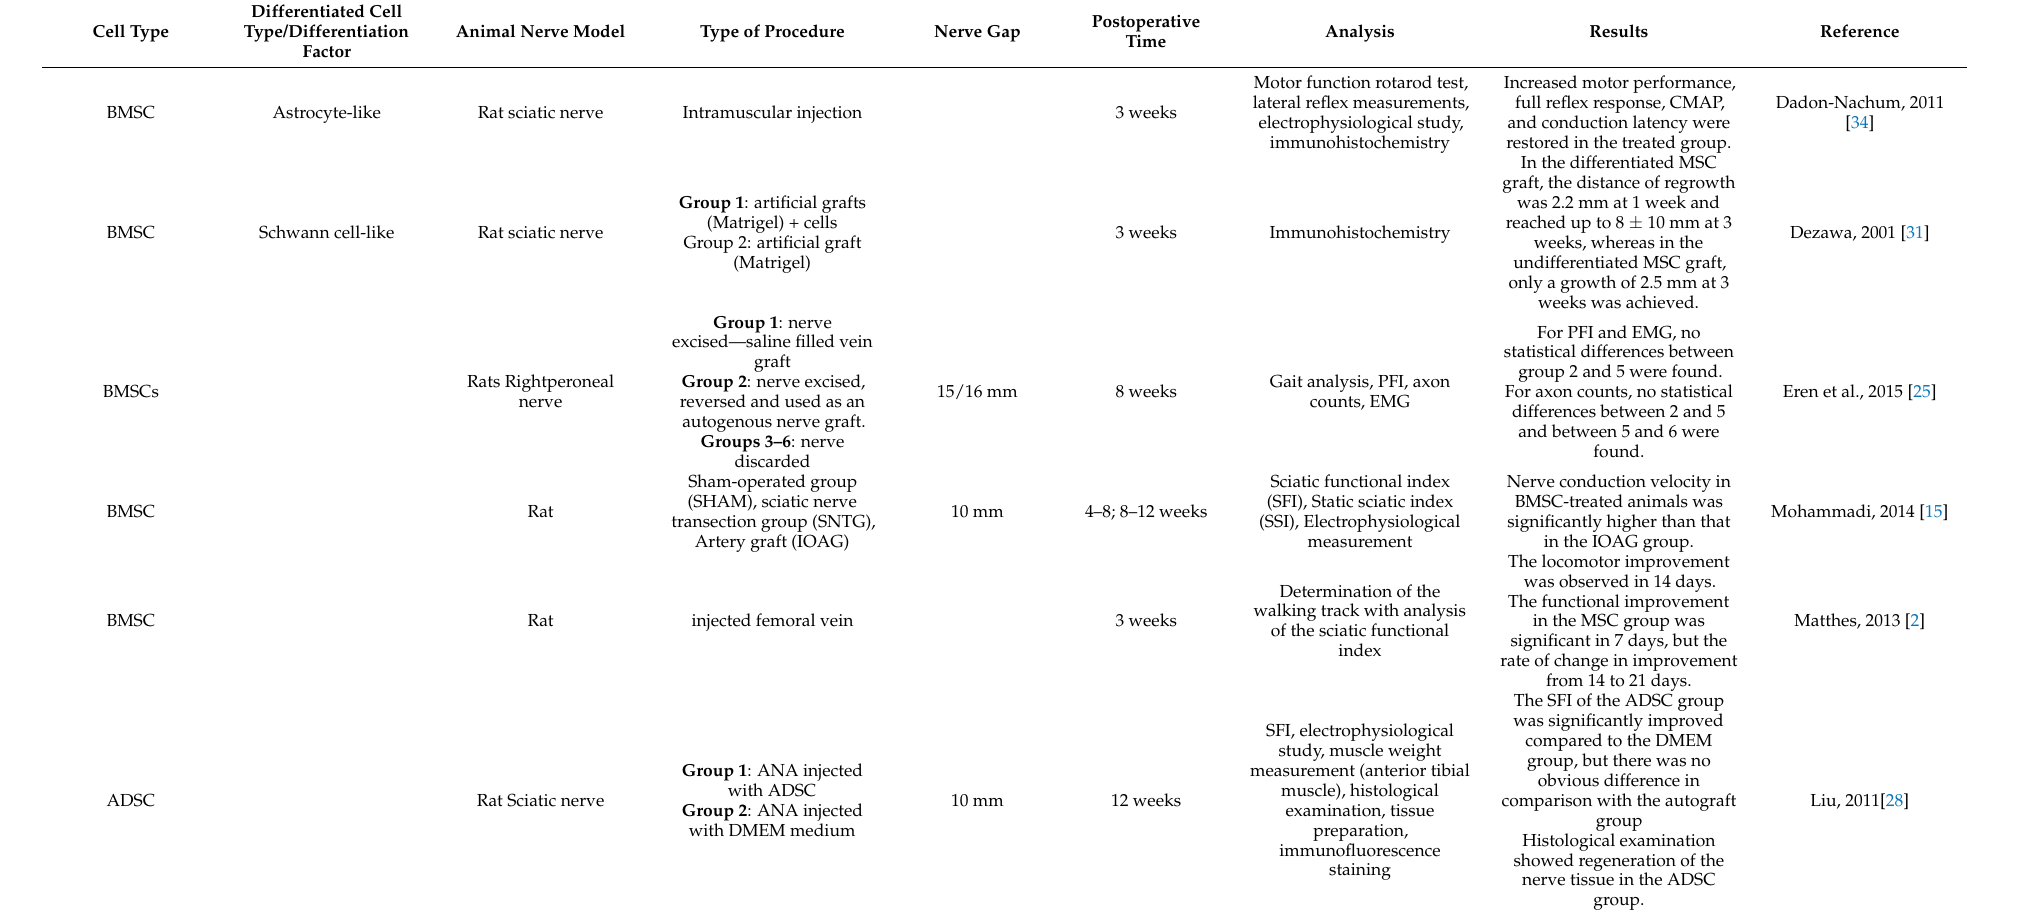
Table 3. Main studies regarding the use of MSCs in nerve